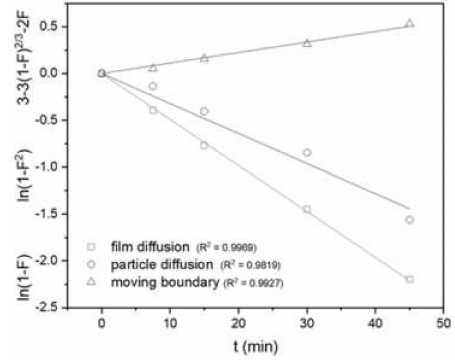
Figure 9. Linear adjustments of the rate law.